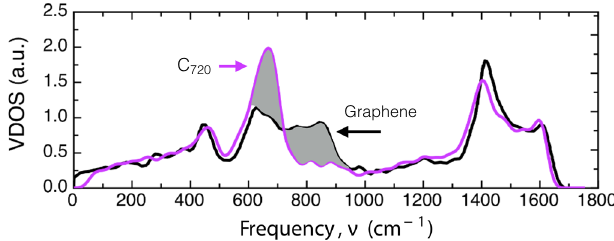
Fig. 2 VDOS comparison between fullerene C 720 and graphene. Bulk graphene VDOS was taken from ref. 65 . The suppressed phonon ZO branch in fullerenes is highlighted by the gray